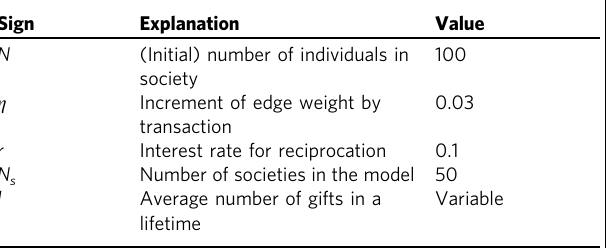
Table 1 Parameters used in the